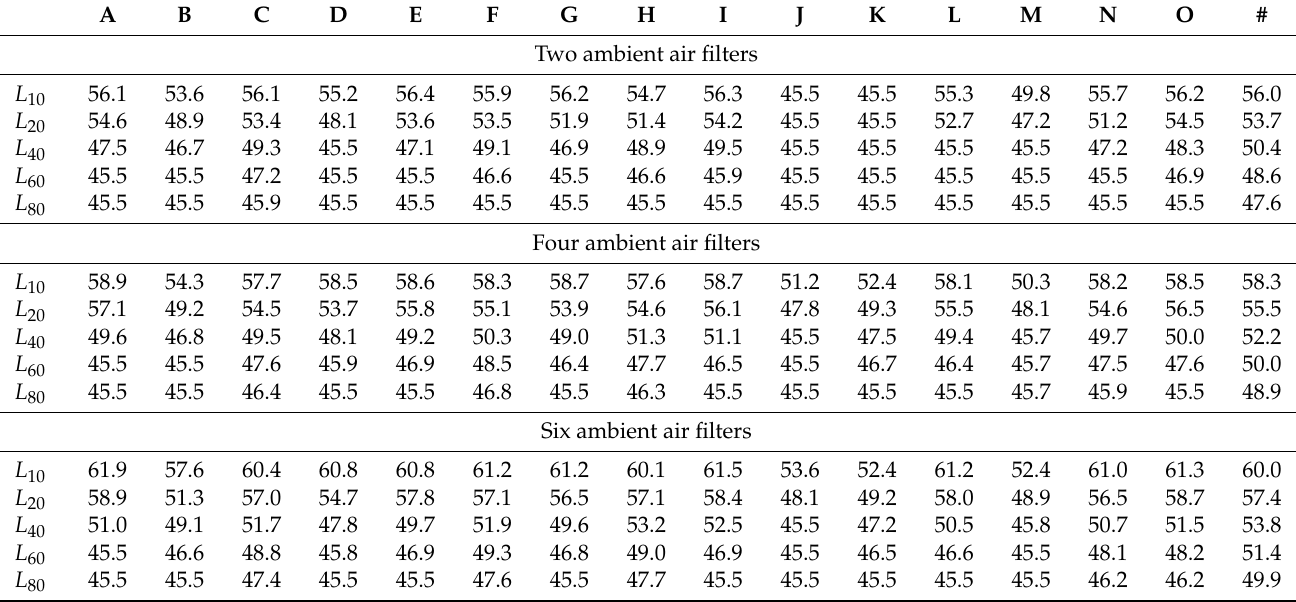
Table 5. Noise distribution indices, L n , of the fifteen selected sites with different number of ambient air filters (unit: dB (A)).